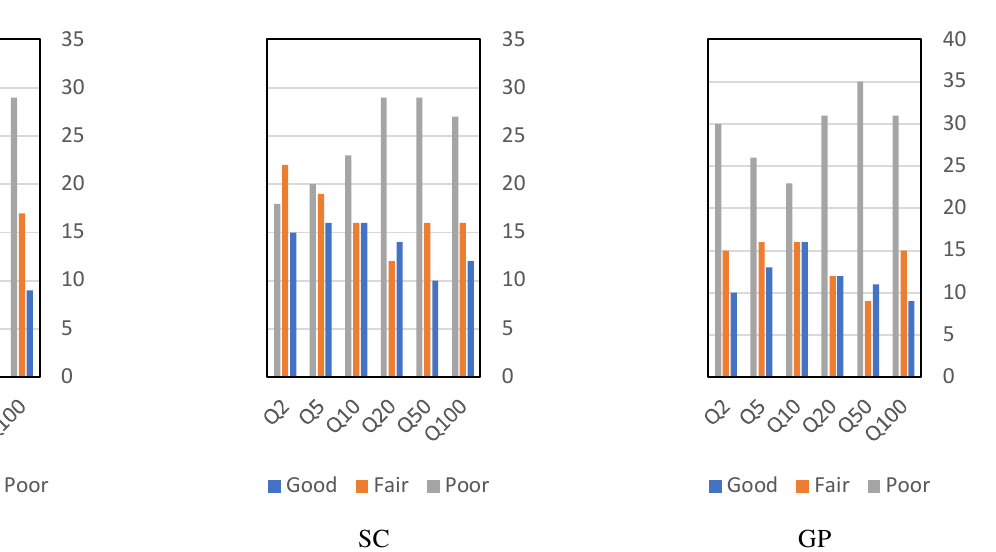
Figure 7. Grouping Q _Ratio values for QRT and IFM models.